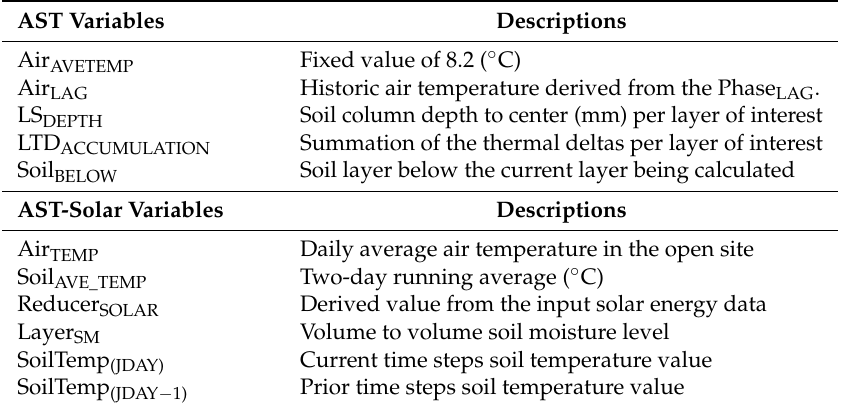
Table 1. AST and AST-Solar subroutine input variables.